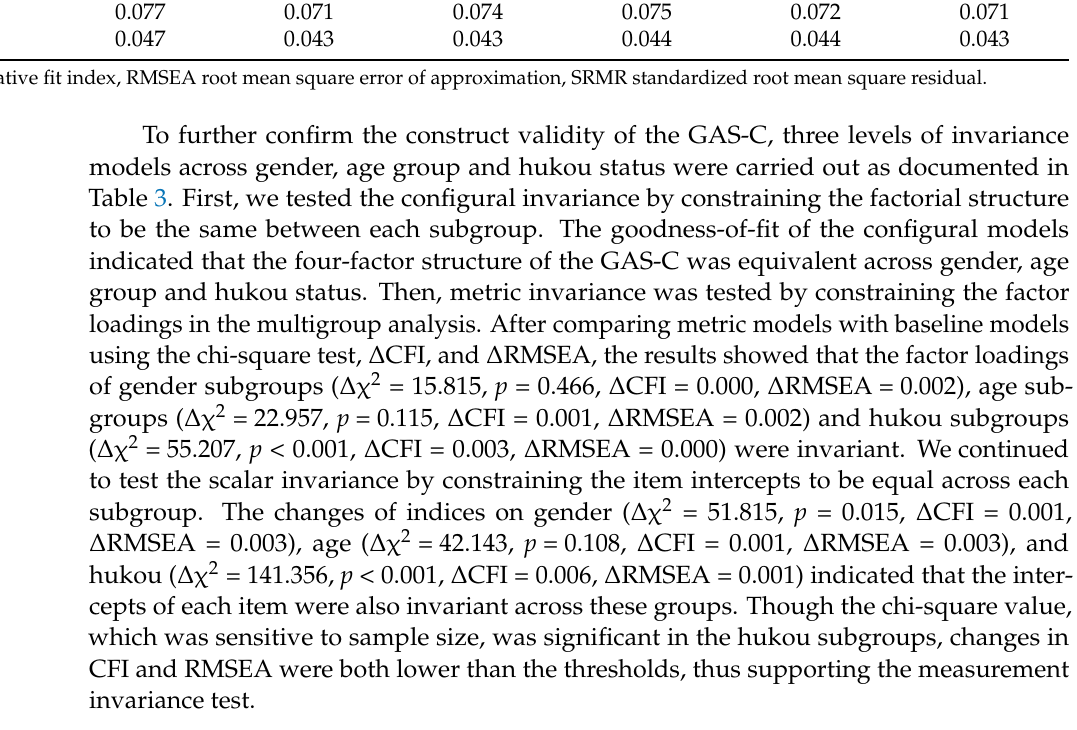
invariance test.